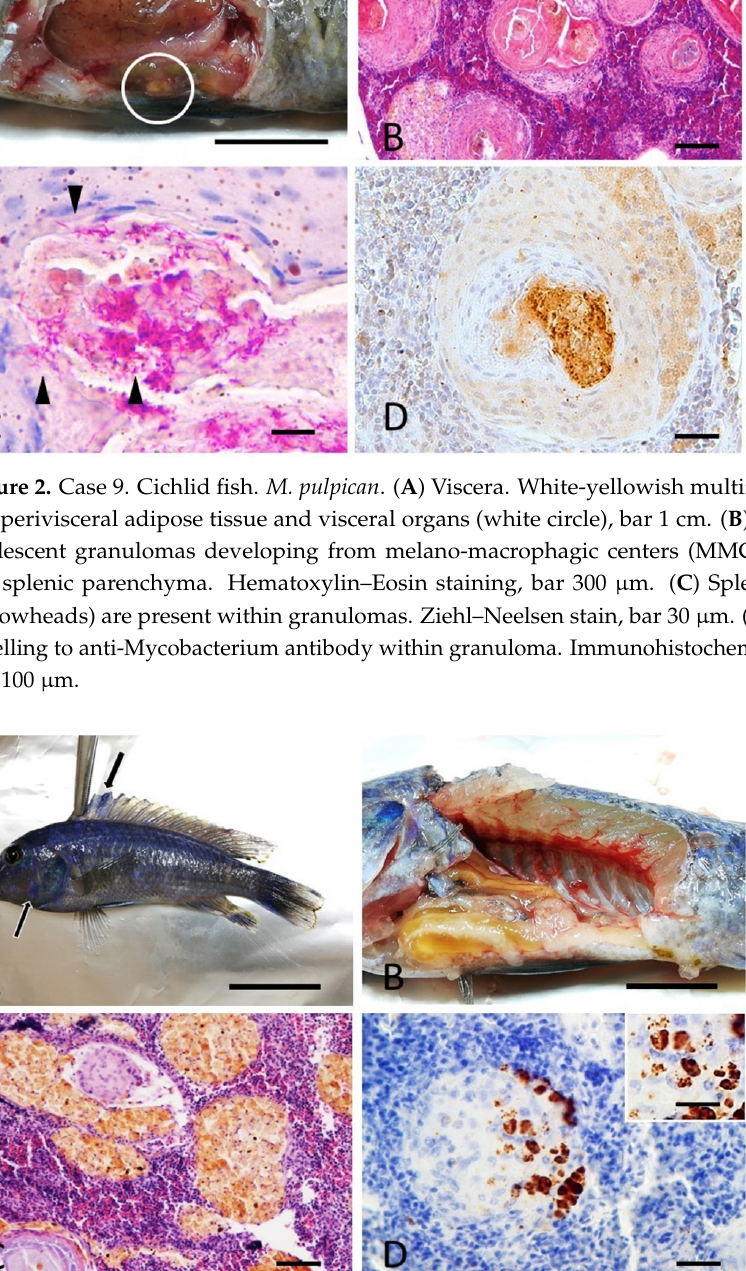
Figure 4. Cases 1 ( A , B ) ( A. jacobfreibergi ) and 5 ( C , D ) ( M. estherae ). Spleen. Comparison between H&E ( A , C bar 100 μm) and IHC ( B , D bar 100 μm) of MMC and granulomas labelling PAB antibody. ( A , C ) Development of granulomas within MMC. ( B , D ) IHC signal associated with macrophages of MMC